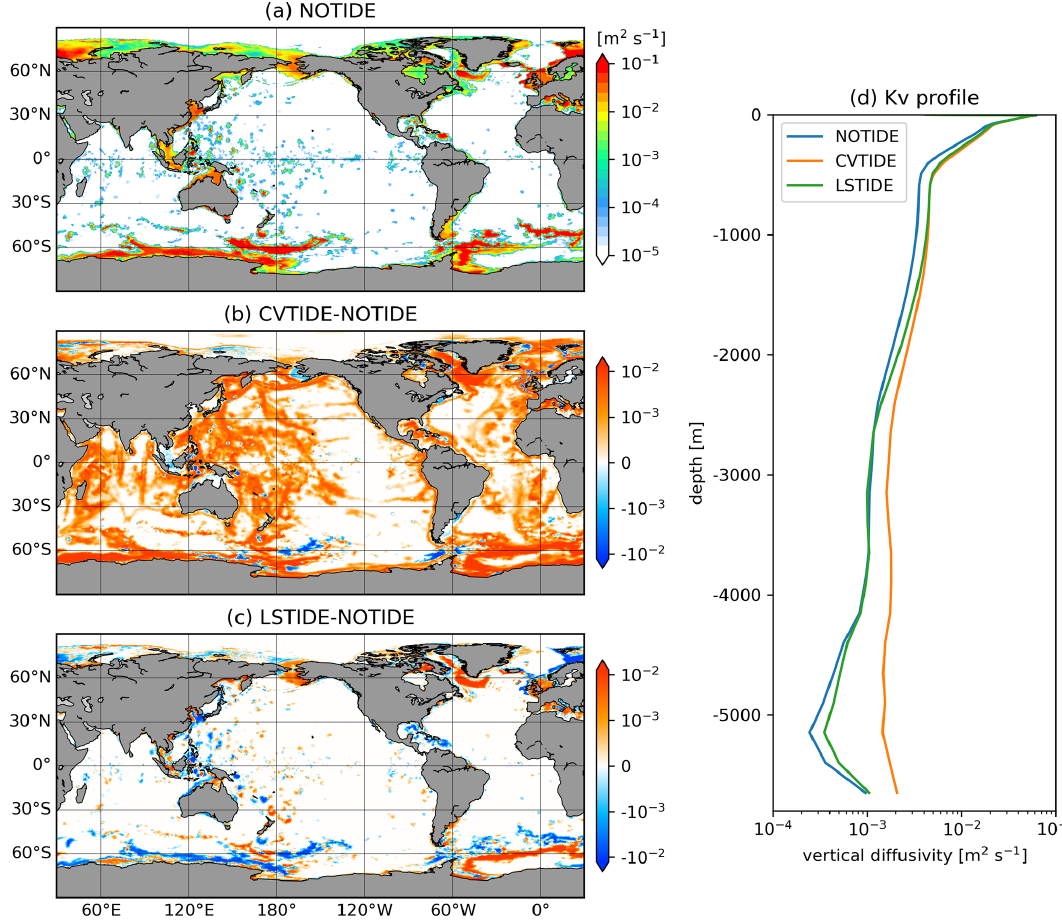
Figure 7. Panels (a) – (c) are horizontal maps of depth-averaged vertical diffusivity over the bottom 500m (average over the whole depth where bathymetry is less than 500m). Panel (d) shows the global mean vertical diffusivity profile in the three sensitivity runs. Colour bars are shown in decimal logarithmic scales. Table 1. A global integration of kinetic energy budget from the model results. The surface wind stress, bottom stress, vertical viscous dissi- pation, horizontal viscous dissipation, buoyancy flux, tidal potential power (Tide), the barotropic potential energy–kinetic energy conversion term (PE2KE) and total kinetic energy (KE) are listed in order in the table. The expressions of these terms can be found in Appendix B1. All except the last term have a unit of terawatts (TW), while kinetic energy has a unit of 10 18 J. Experiment ID Wind stress Bott. stress Vert. visc. Horiz. visc. Buoy. flux Tide PE2KE KE NOTIDE 3 . 11 − 0 . 18 − 2 . 19 − 0 . 17 − 0 . 58